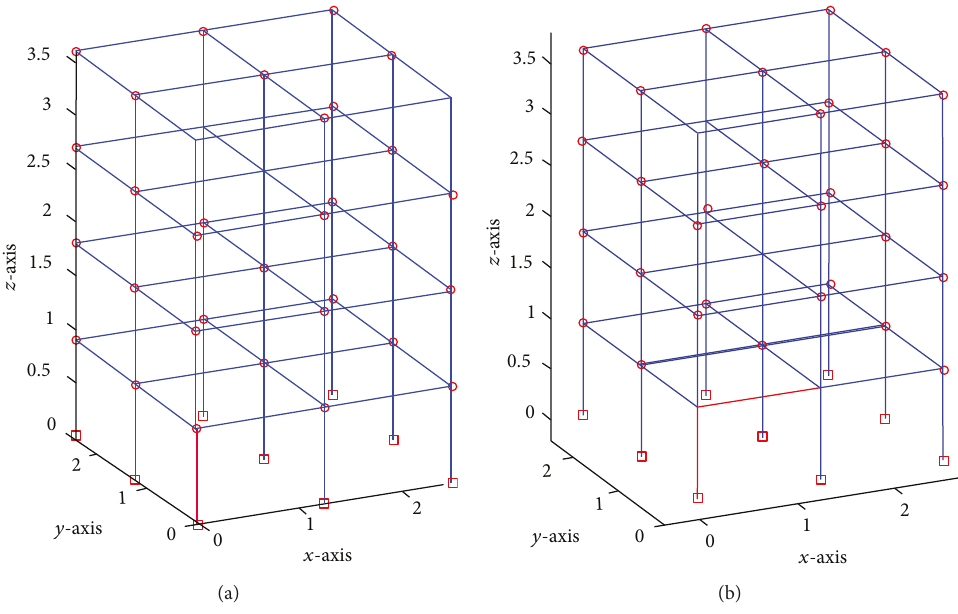
Figure 2: Damage scenarios: (a) scenario 1 and (b) scenario 2.